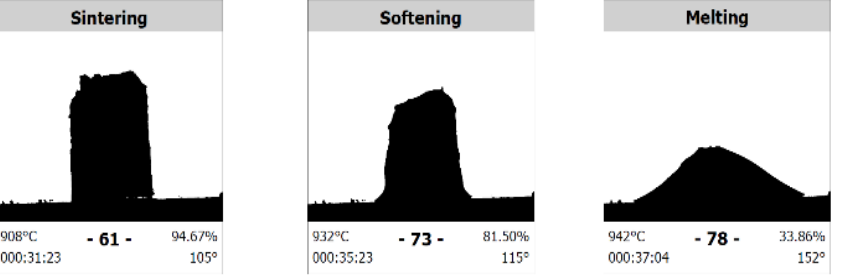
Figure 12. Sample pictures taken by the Hot Stage Microscopy camera for sintering, softening and melting temperatures of C1 powder.